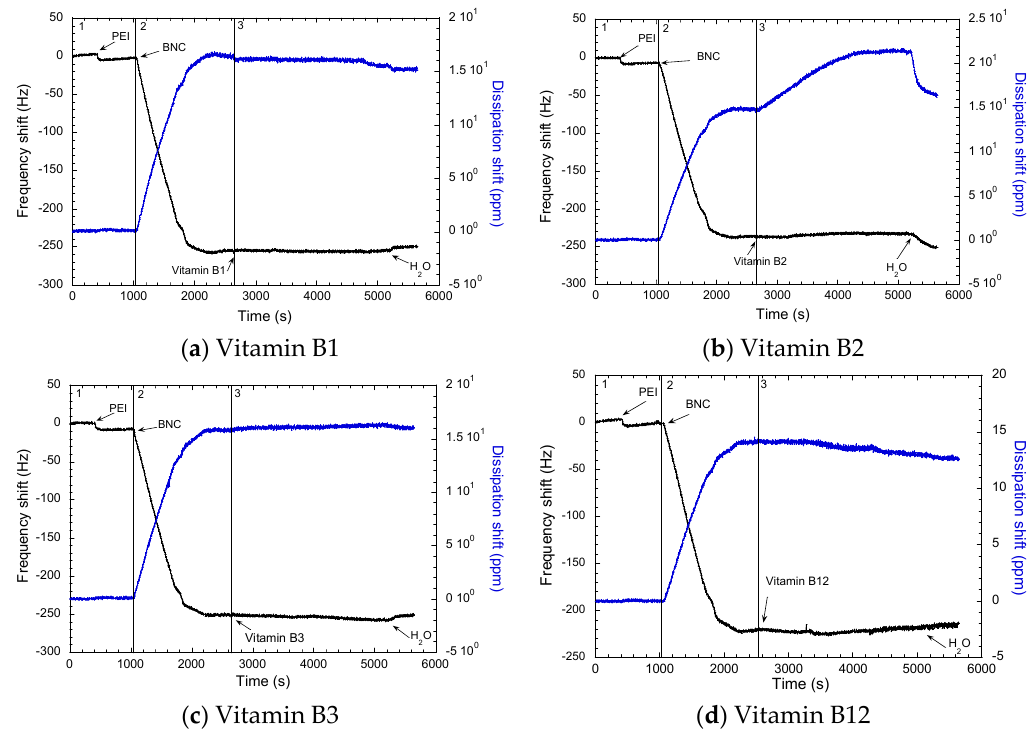
Figure 1. The shift in dissipation, ∆ D, and frequency, ∆ F from Quartz Crystal Microbalance (QCM-D) adsorption of vitamins: ( a ) B1, ( b ) B2, ( c ) B3, and ( d ) B12. ∆ F = change in frequency (black line) and ∆ D = dissipation (blue line). Adsorption zones: a (polyethylenimine, PEI), b (bacterial nanocellulose, BNC), and c (vitamin).